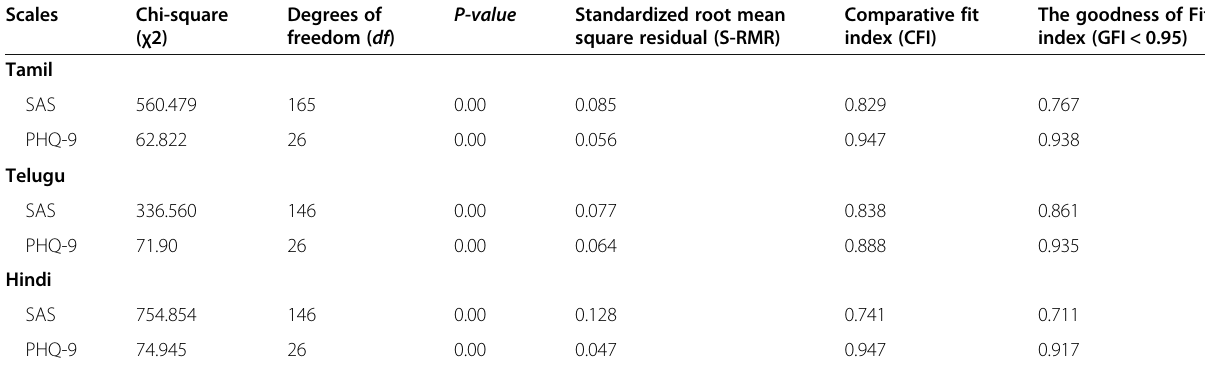
Table 3 Goodness of fit indices of SAS and PHQ-9 obtained from confirmatory factor analysis Scales